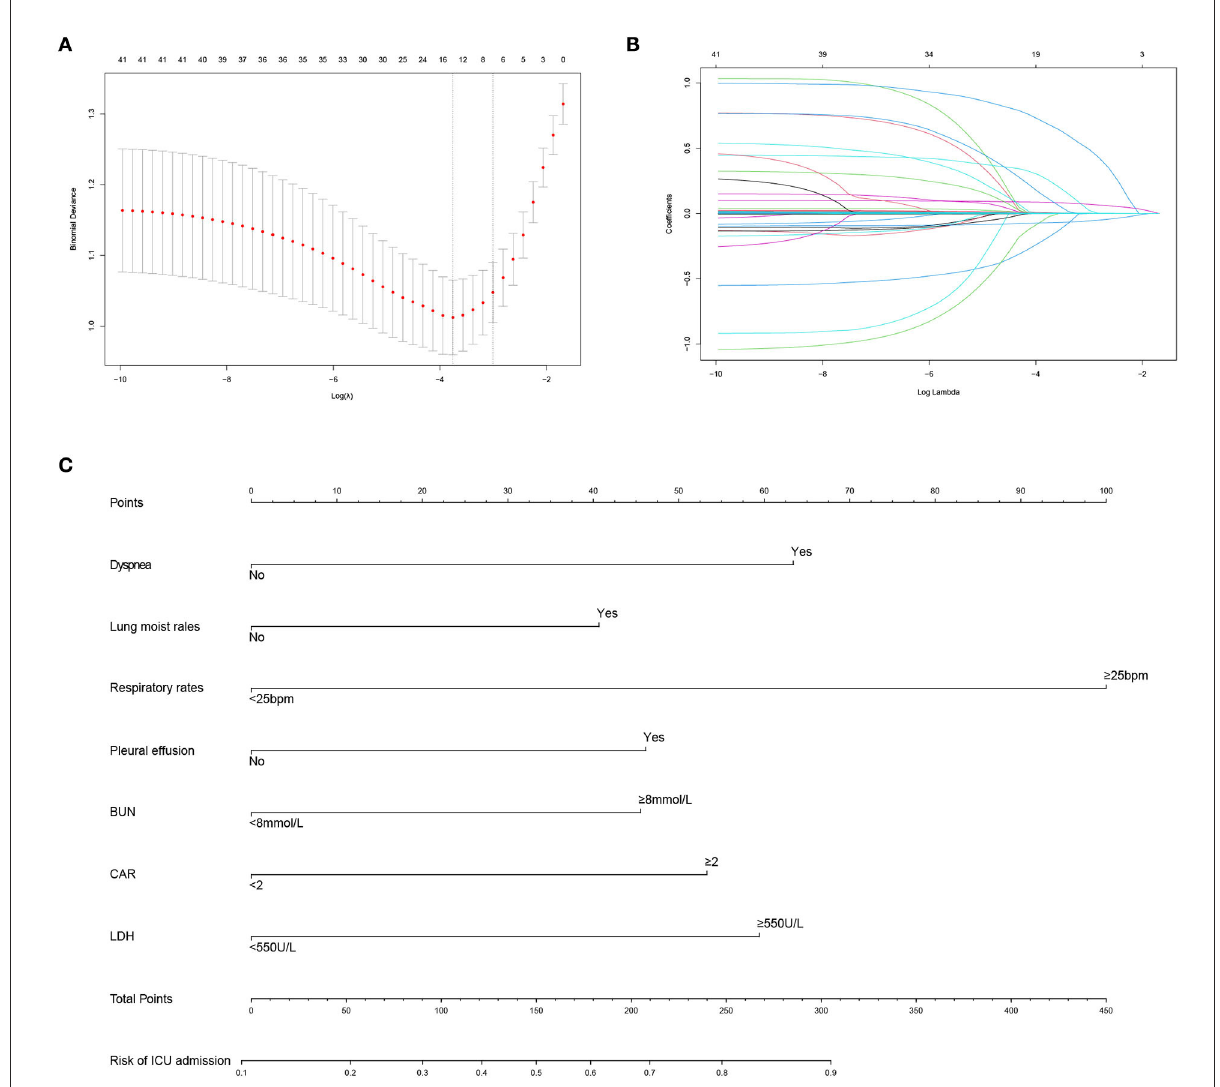
FIGURE4 Predictor selection and prognostic nomogram development for predicting ICU admission of patients with PCP. (A) Identification of optimal parameters (lambda) in the LASSO model using minimum criteria and 5-fold cross-validation. Dotted vertical lines are drawn at the selected values using the minimum criteria and the 1 standard error of the minimum criteria (1-SE criteria); (B) LASSO coefficient profiles of 41 features; (C) prognostic nomogram formulated for predicting ICU admission of patients with PCP. LASSO, least absolute shrinkage and